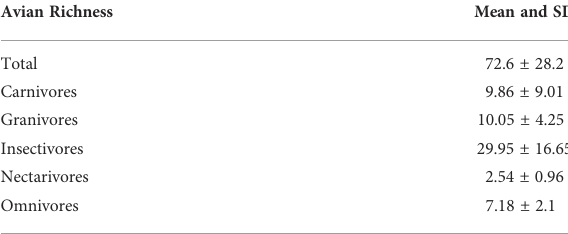
TABLE 2 The mean and standard deviation of richness by foraging guild.